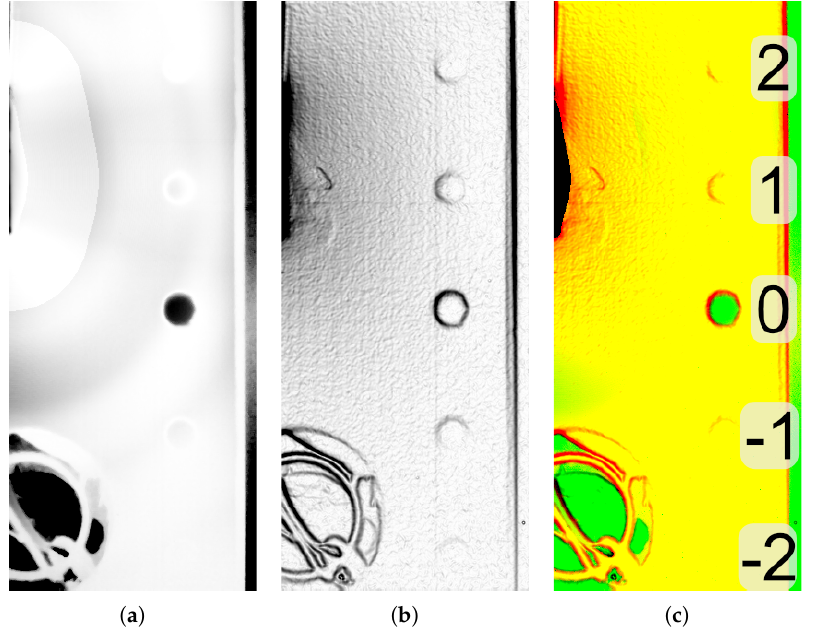
Figure 5. The measurement of area I (rotated by 90°) with the IPHWT results in two images based on the covariance analysis ( a ) and local gradient method ( b ). Combining both methods results in an image in which green corresponds to the covariance analysis and red corresponds to the local gradient method ( c ). Additionally, the identified heating area is indicated in black at the top left region.